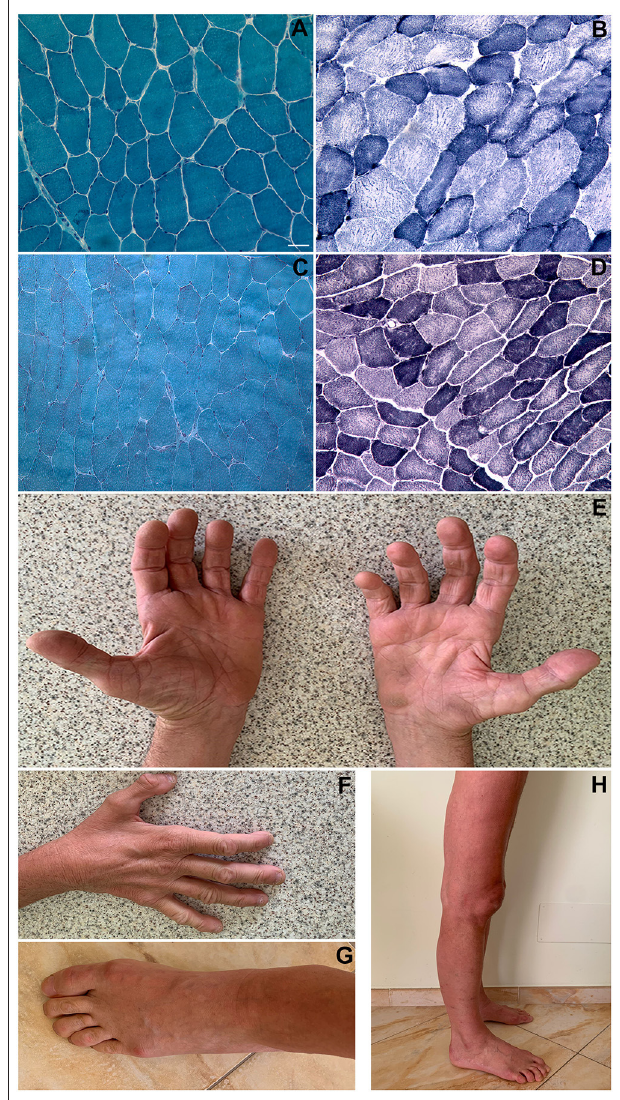
FIGURE 1 | Histopathological findings. Patient 1 (biceps brachii muscle; magnification: 200x): Gomori trichrome stain showing a slightly increased variability in muscle fibers diameter; no rimmed vacuoles and no sarcoplasmic or intranuclear inclusions were present (A) . NADH-TR stain showing “moth-eaten” or “core-like” areas of oxidative enzyme activity reduction in both fiber types and increased subsarcolemmal activity in some type I fibers (darker blue areas) (B) . Patient 2 (vastus lateralis muscle; magnification: 200x): Gomori trichrome stain showing an almost normal fiber variability pattern; no rimmed vacuoles and no inclusions were present (C) . NADH-TR stain shows slightly “core-like” reduction of central oxidative enzyme activity in both fiber types (D) . Patient 1 pictures showing intrinsic hand, foot, leg and thigh muscles wasting (E–H) . Scale bar: 25 µ